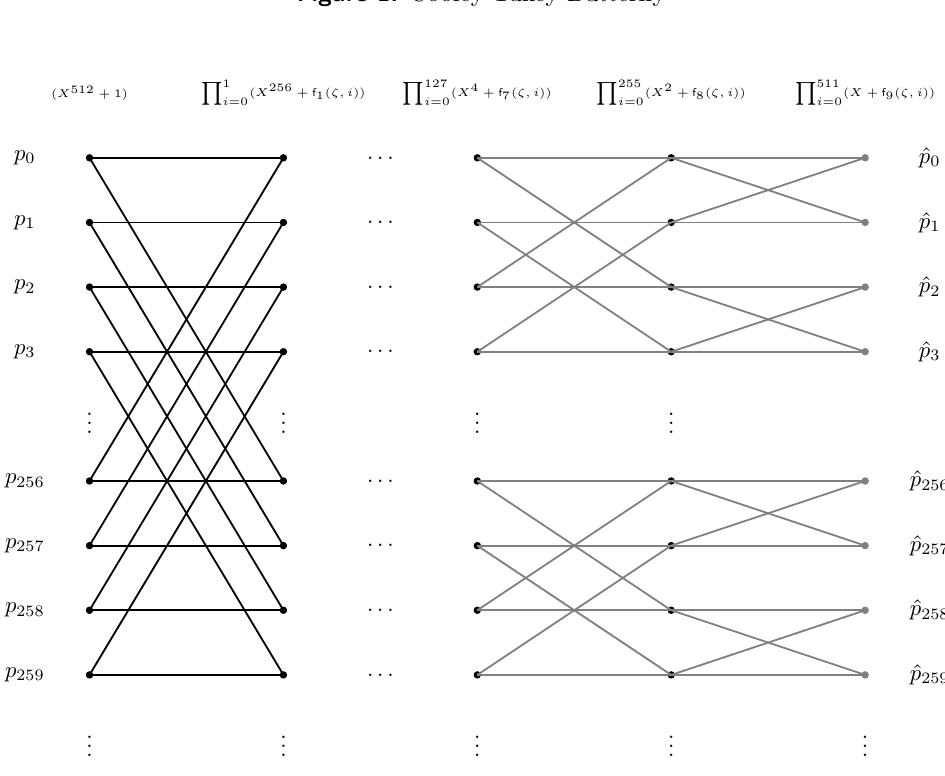
Figure 1: Cooley-Tukey Butterfly